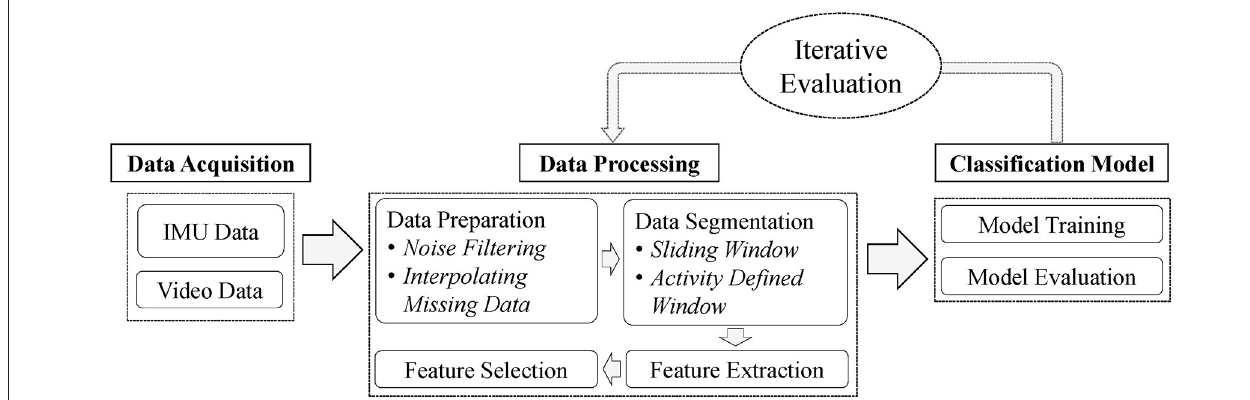
FIGURE 1 | Framework for equipment activity identification.